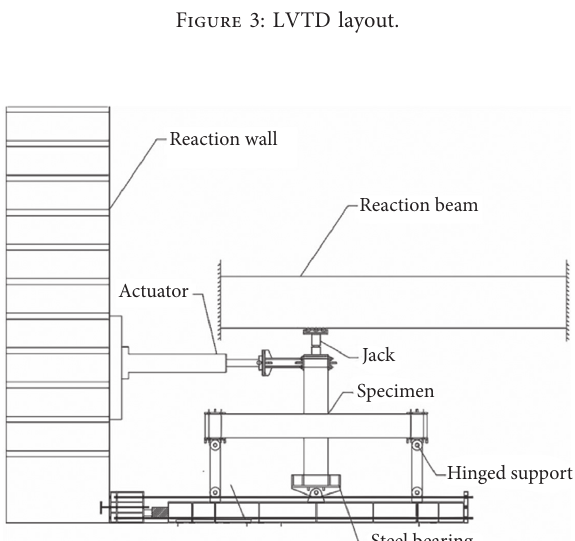
Figure 4: Loading device.